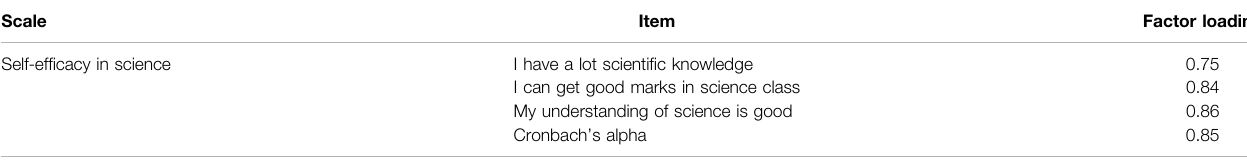
TABLE 2 | Summary of rotated factor analysis loading results > 0.35 for 3 items on Self-ef fi cacy in science in the post-presenting survey.